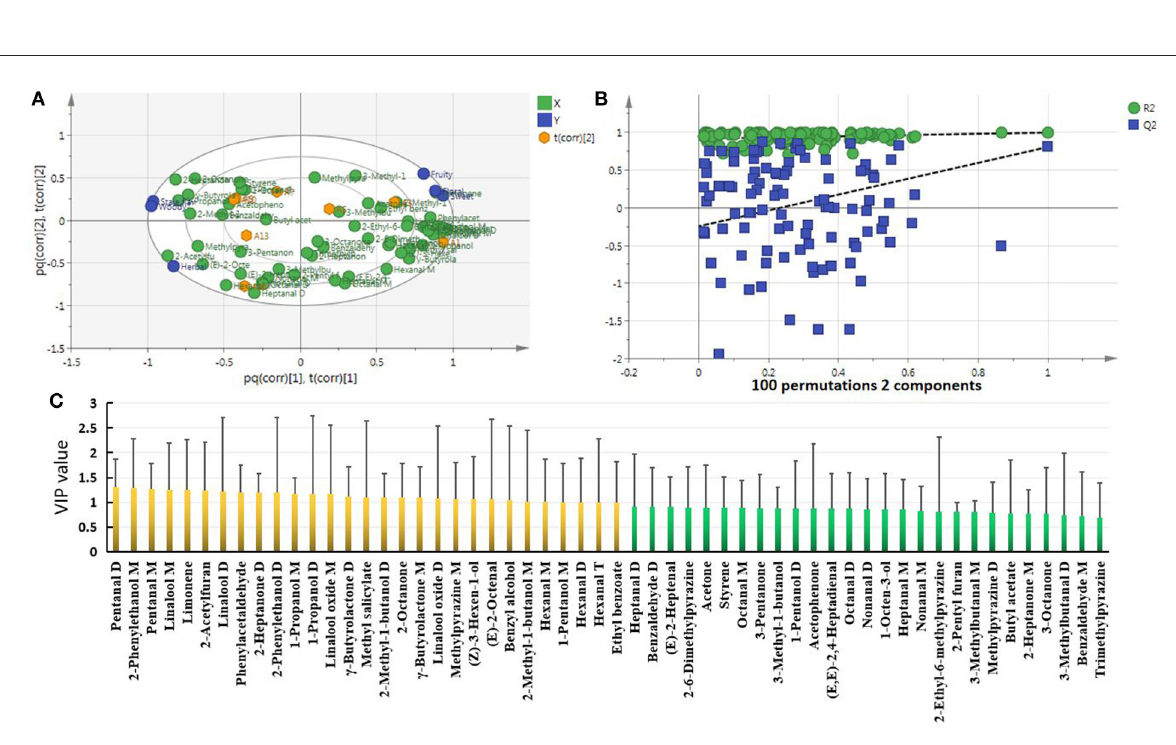
FIGURE5 Screening of important aroma components during CWT storage. (A) OPLS-VIP model. R 2 X = 0.973, R 2 Y = 0.976, Q 2 = 0.616. (B) Cross validation of OPLS-VIP model. (C) VIP value of